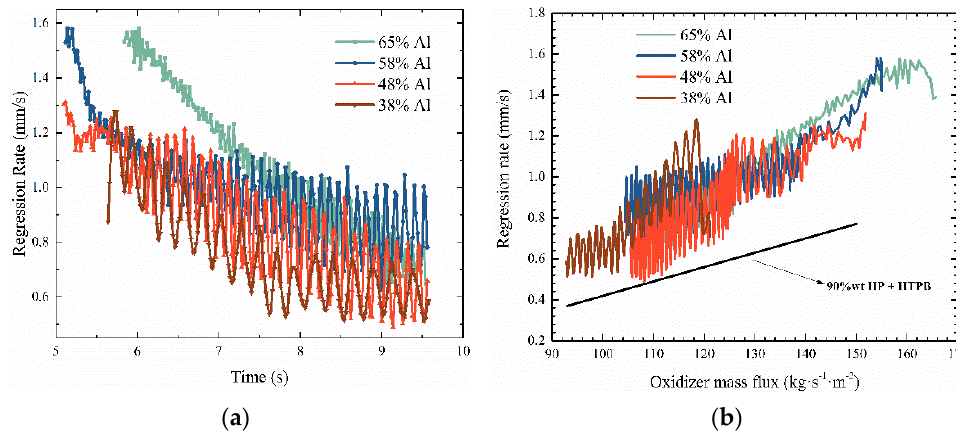
Figure 5. Instantaneous regression rate versus time and oxidizer mass flux. ( a ) Instantaneous regression rate versus time. ( b ) Instantaneous regression rate versus oxidizer mass flux. Table 3. Performance results.